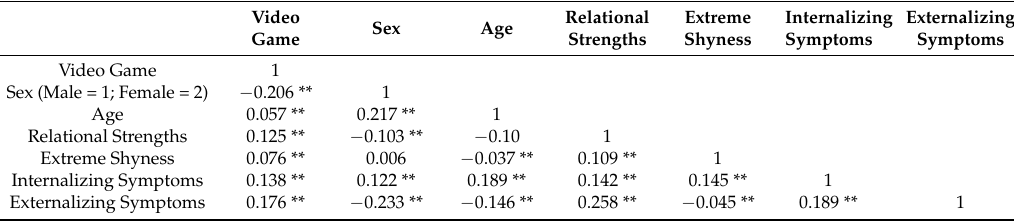
Table A1. Zero-order correlations between all